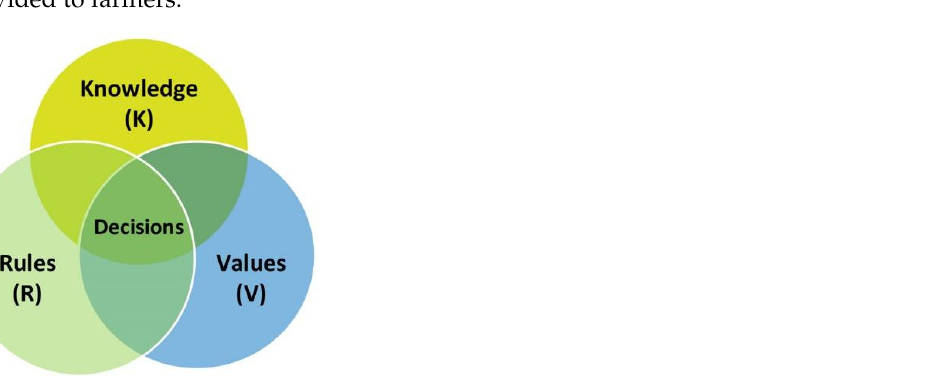
Figure 1. Values, rules, knowledge, and the decision context (adapted from Gorddard et al., 2016).